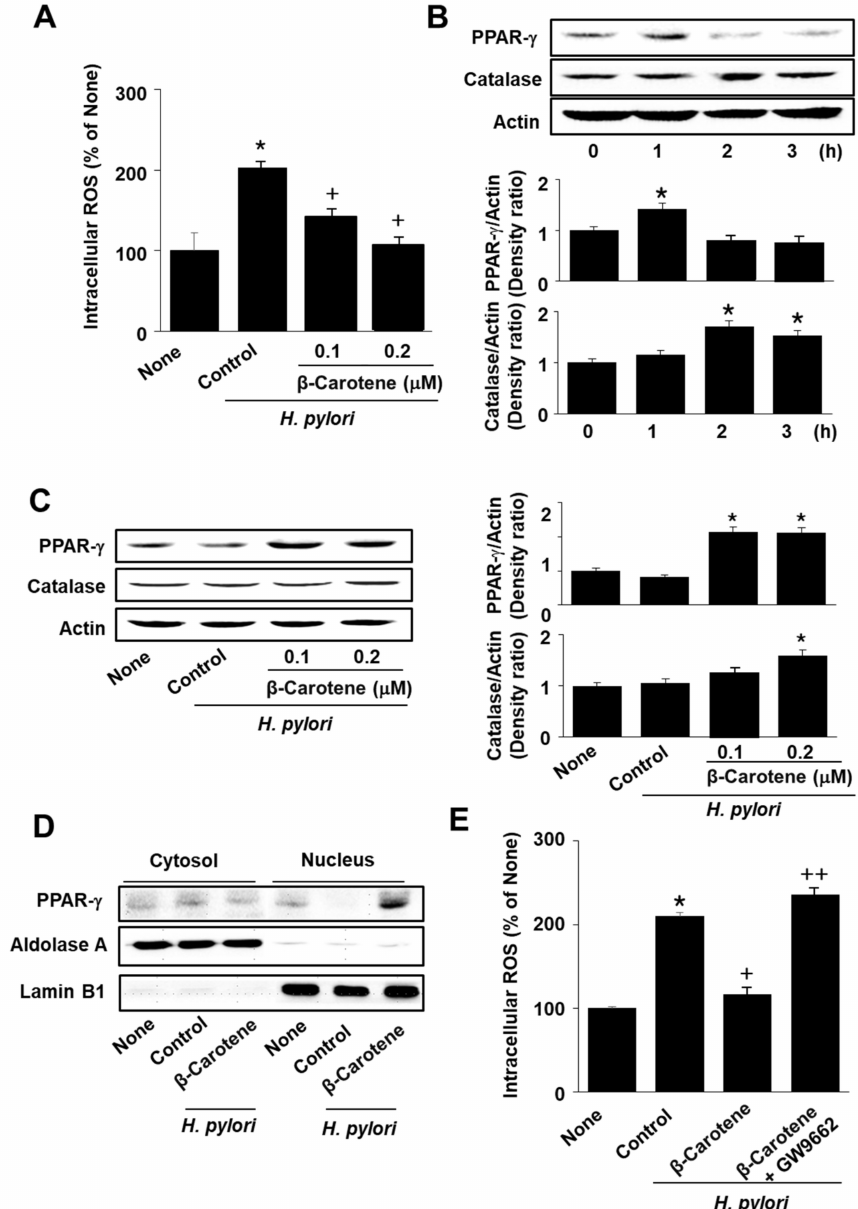
Figure 5. β -Carotene reduces intracellular ROS levels and induces expression of PPAR- γ and catalase in H. pylori -infected AGS cells. ( A , C ) Cells were pretreated with the indicated concentrations of β -carotene for 2 h and then infected with H. pylori for 30 min. ( B ) Cells were treated with β -carotene (0.2 µ M) for the indicated time period without H. pylori infection. ( D ) Cells were pretreated with β -carotene (0.2 µ M) for 2 h and then infected with H. pylori for 30 min. ( E ) Cells were co-treated with the PPAR- γ antagonist GW9662 (5 µ M) and β -carotene (0.2 µ M) for 2 h and then infected with H. pylori for 30 min. ( A , E ) Intracellular ROS levels were measured by dichlorofluorescein (DCF) fluorescence. All data are shown as the mean ± S.E. of three independent experiments. ROS levels in none (the cells without any treatment or infection) were set as 100%. * p < 0.05 vs. none (cells without any treatment or infection); + p < 0.05 vs. control (cells with H. pylori infection alone); ++ p < 0.05 vs. cells with β -carotene treatment and H. pylori infection. ( B , C ) Protein levels of PPAR- γ and catalase in whole-cell extracts were determined by Western blot analysis, using actin as the loading control. The densitometry data represent means ± S.E. from three immunoblots and are shown as relative density of protein band normalized to actin level. * p < 0.05 vs. 0 h ( B ) or control (cells with H. pylori infection alone) ( C ). ( D ) Levels of PPAR- γ were measured by Western blot analysis. Aldolase was used as a marker of cytosol, while lamin B was used as a nuclear